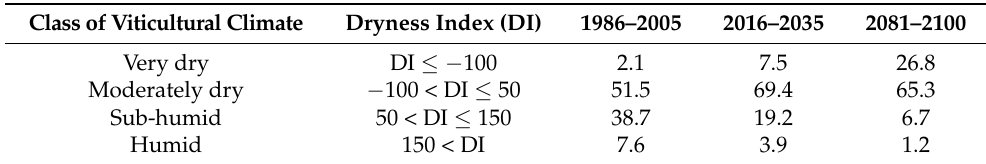
Table 4. The proportion of the three types of dry spells (%) defined from the DI values in the 22 Hungarian wine regions in the three investigated periods, i.e., recent past (1986 – 2005), near future (2016 – 2035), and distant future (2081 – 2100). The categories and their limits in the second column of the Table are defined by [33].